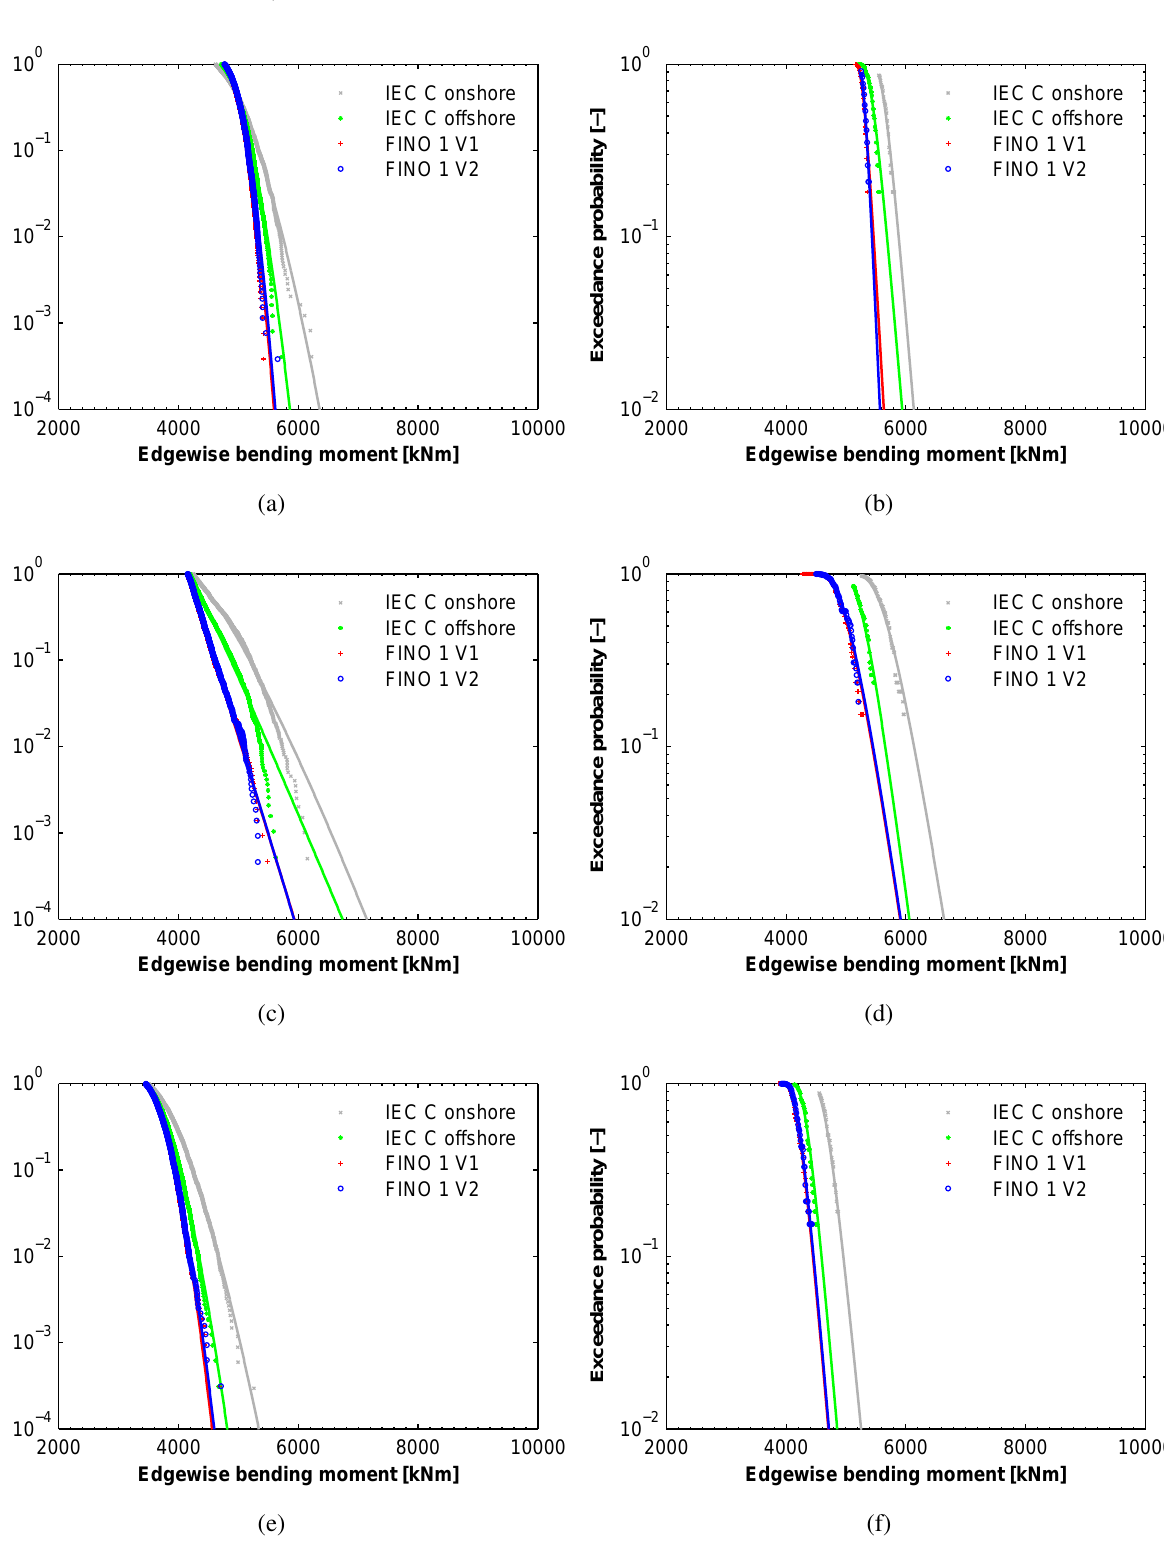
Figure 10. Local exceedance probability distribution for the edgewise bending moment at the blade root (please notice the different scales of the y-axis). ( a ) POT, v = 11 m/s ; ( b ) ACER, v = 11 m/s ; ( c ) POT, v = 13 m/s ; ( d ) ACER, v = 13 m/s ; ( e ) POT, v = 21 m/s ; ( f ) ACER, v = 21 m/s